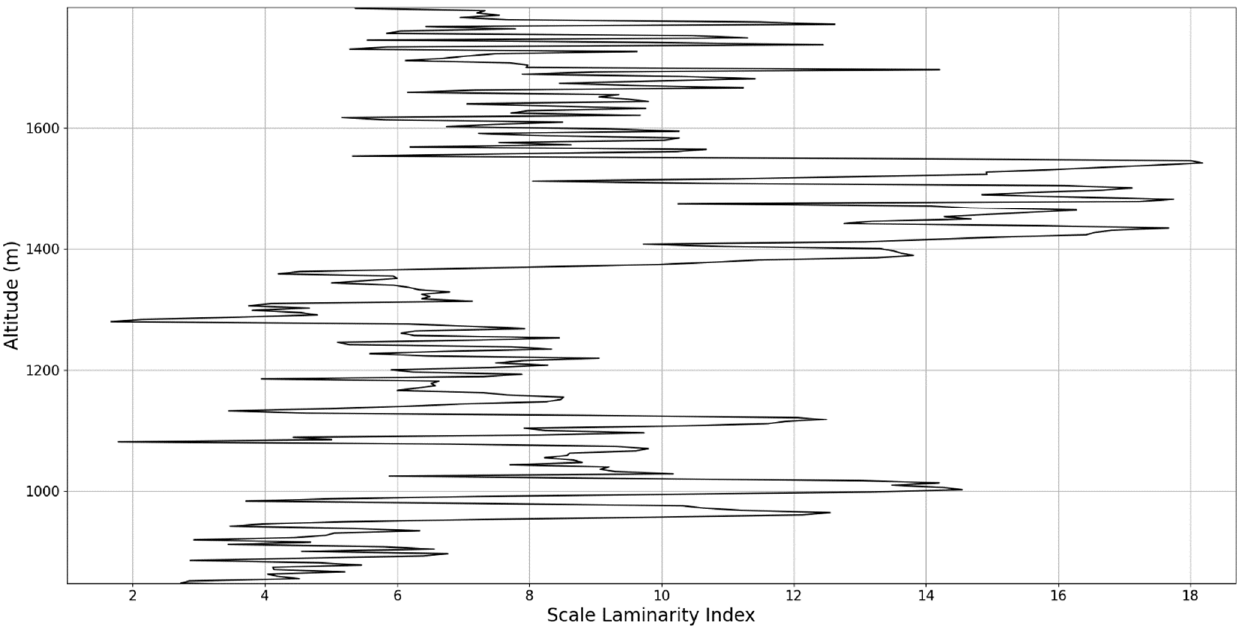
Figure 33. Zoomed-in scale laminarity index profile plot corresponding to point C.